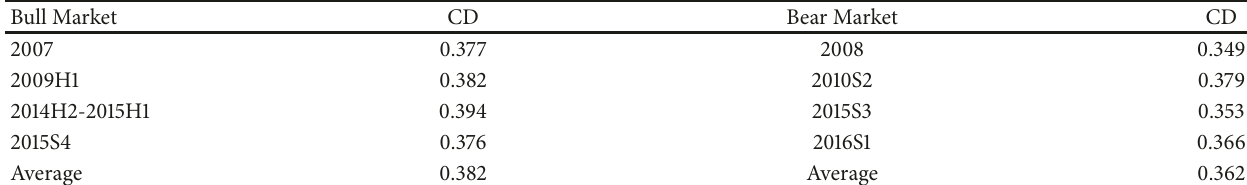
Table 4: Contrarian degree of bull and bear markets.